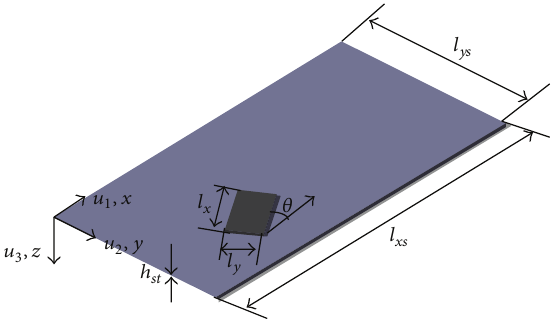
Figure 1: Flexible plate and orientation of piezoelectric